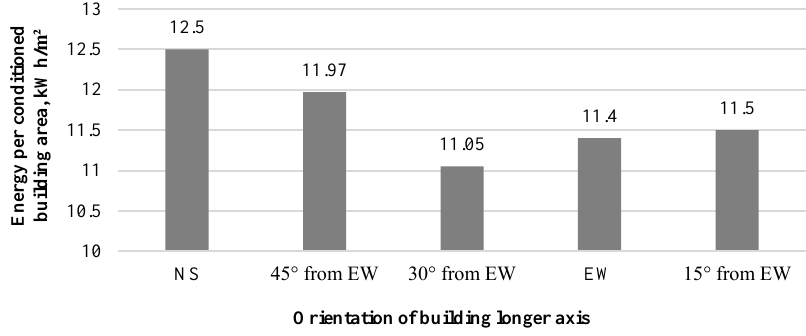
Fig. 11. Summer design week energy consumption with respect to building